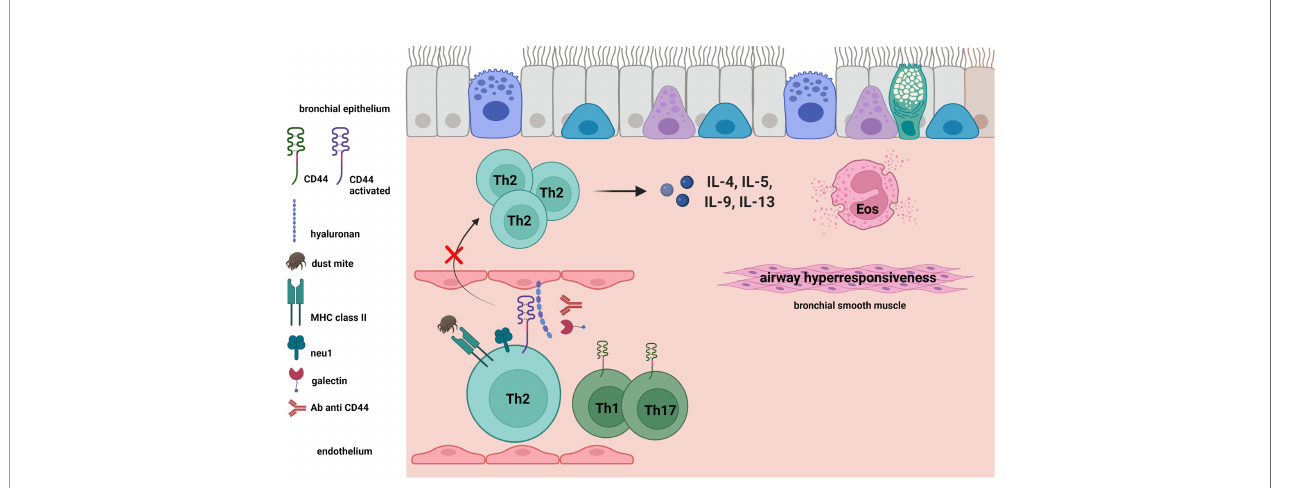
FIGURE 1 | Antigen-induced activation of CD44 expressed on Th2 cells. CD44 receptor activity for hyaluronan (HA) and expression of neuraminidase 1 (Neu1) on Th2 cells were induced by antigen challenge in a mouse model of acute asthma. We demonstrated the importance of Th2 cell recruitment in the bronchus by CD44- HA interactions in the pathogenesis of acute allergic asthma in an experimental mouse model. Galectin-9 and anti-CD44 mAb inhibit the CD44-HA interaction, as well as the following Th2-mediated eosinophilic airway in fl ammation and airway